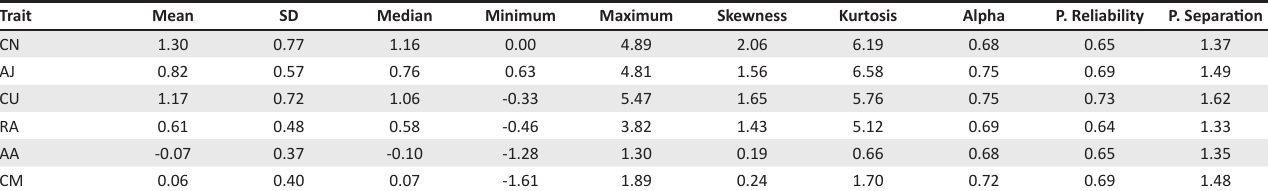
TABLE 3: Descriptive statistics of person measure scores and reliability indices of Each High Potential Trait Indicator trait.